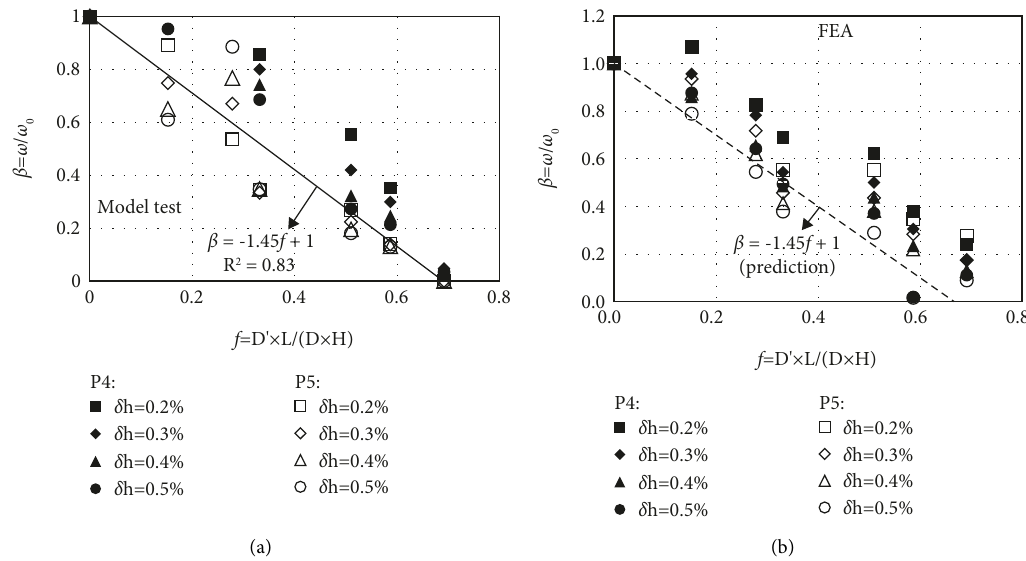
Figure 18: The coefficient of settlement reduction (at P4 and P5) at different retaining wall movements. (a) Physical model test and (b) FEA. Table 2: The input parameters of HSS. Parameter and unit Dry sand Constitutive model HSS Unit weight (kN/m 3